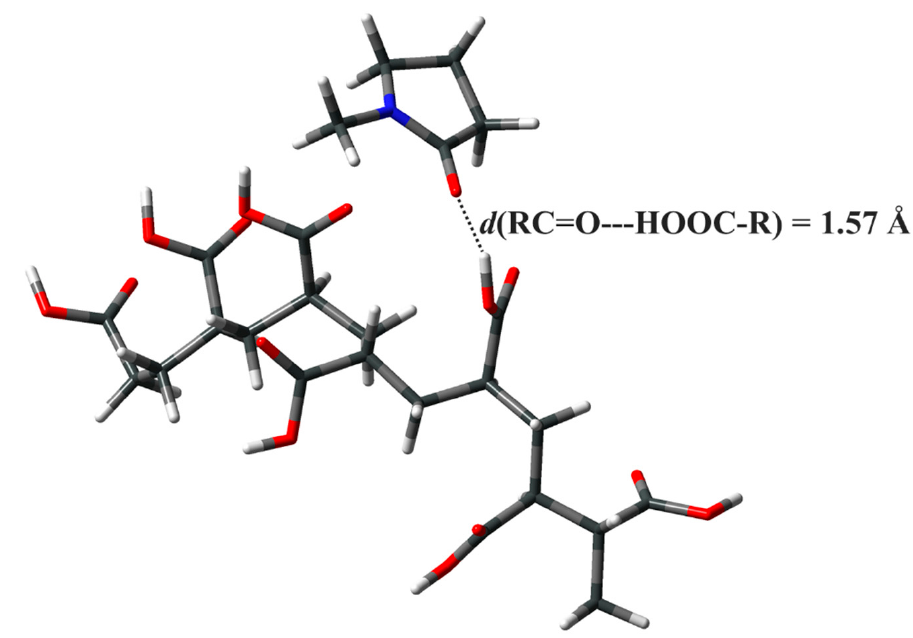
Figure 1. O-HO distance in the optimized complex of PAA and NMP.